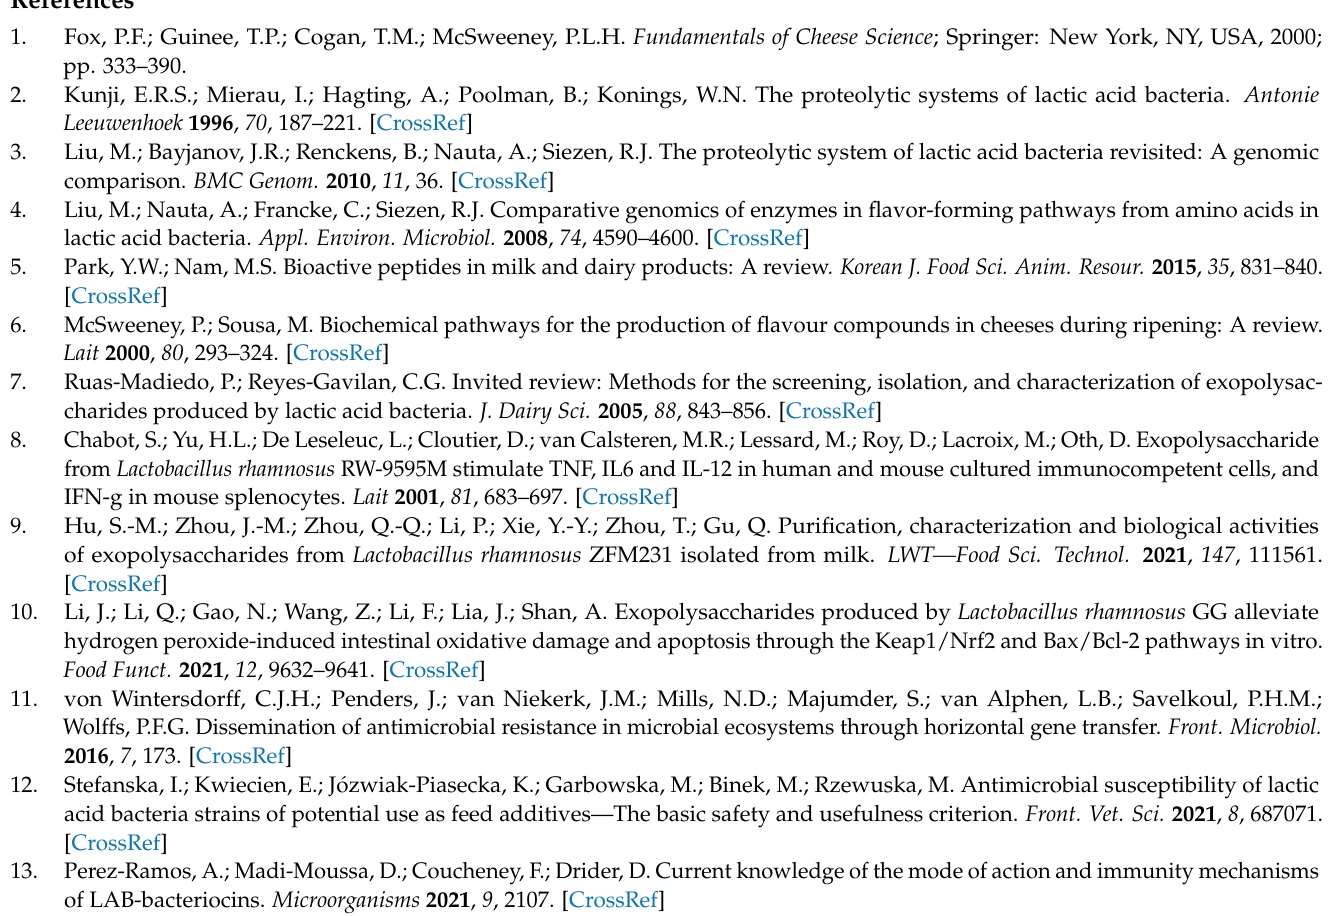
included in the present study to PBS buffer adjusted to pH 2 (blue) or 3 (green) with HCl and incubation at 37 ◦ C for 3 h. N: microbial population after incubation; N 0 : initial microbial population. Figure S2: Microbial survival (in log N/N 0 ) after exposure of E. faecalis ( A ), E. faecium ( B ), Lc. lactis ( C